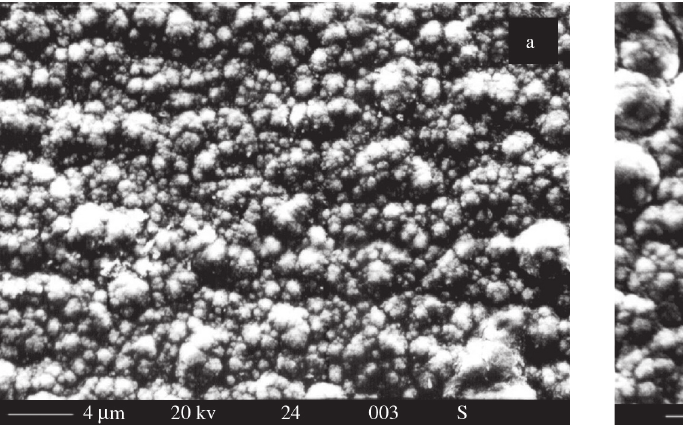
Figure 2. Morphology of coatings from Bath 2: a) 116 A/m 2 ; b) 154 A/m 2